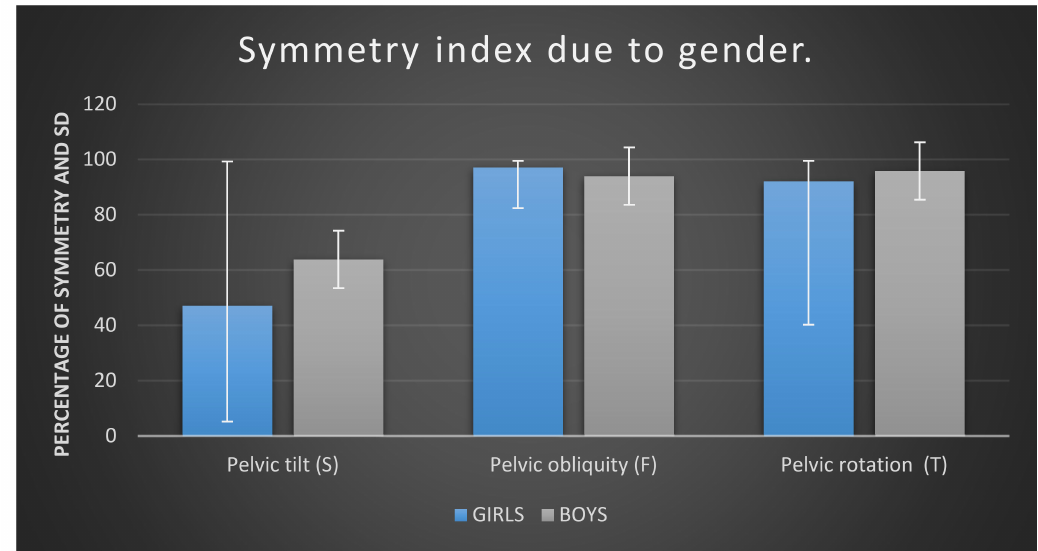
Figure 7. Symmetry index of pelvic tilt, pelvic obliquity, and pelvic rotation in examined children, shown as mean according to gender Detailed analysis of the results is presented in Table 4. Table 4. Gait symmetry parameters due to gender of examined children. Gait